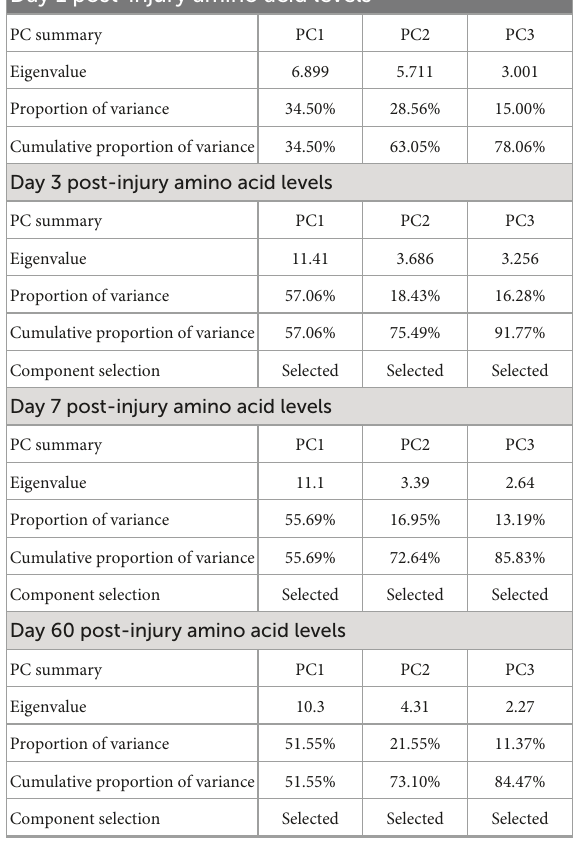
TABLE 1 Summary of the principle components selected from the amino acid panels at day one, three, seven, and sixty post-injury for use in the voxel-wise regression analysis with neurite orientation dispersion and density imaging (NODDI) metric maps obtained at day 60 post-injury in traumatic brain injured